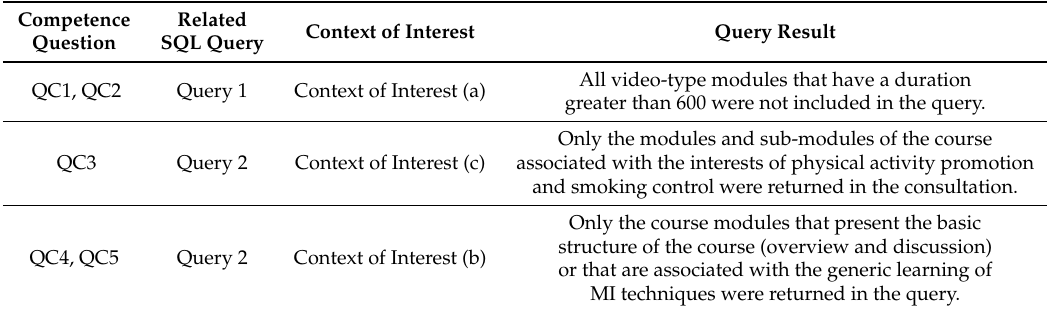
Table 10. Analysis of contexts and queries related to each competence issue and the results of each